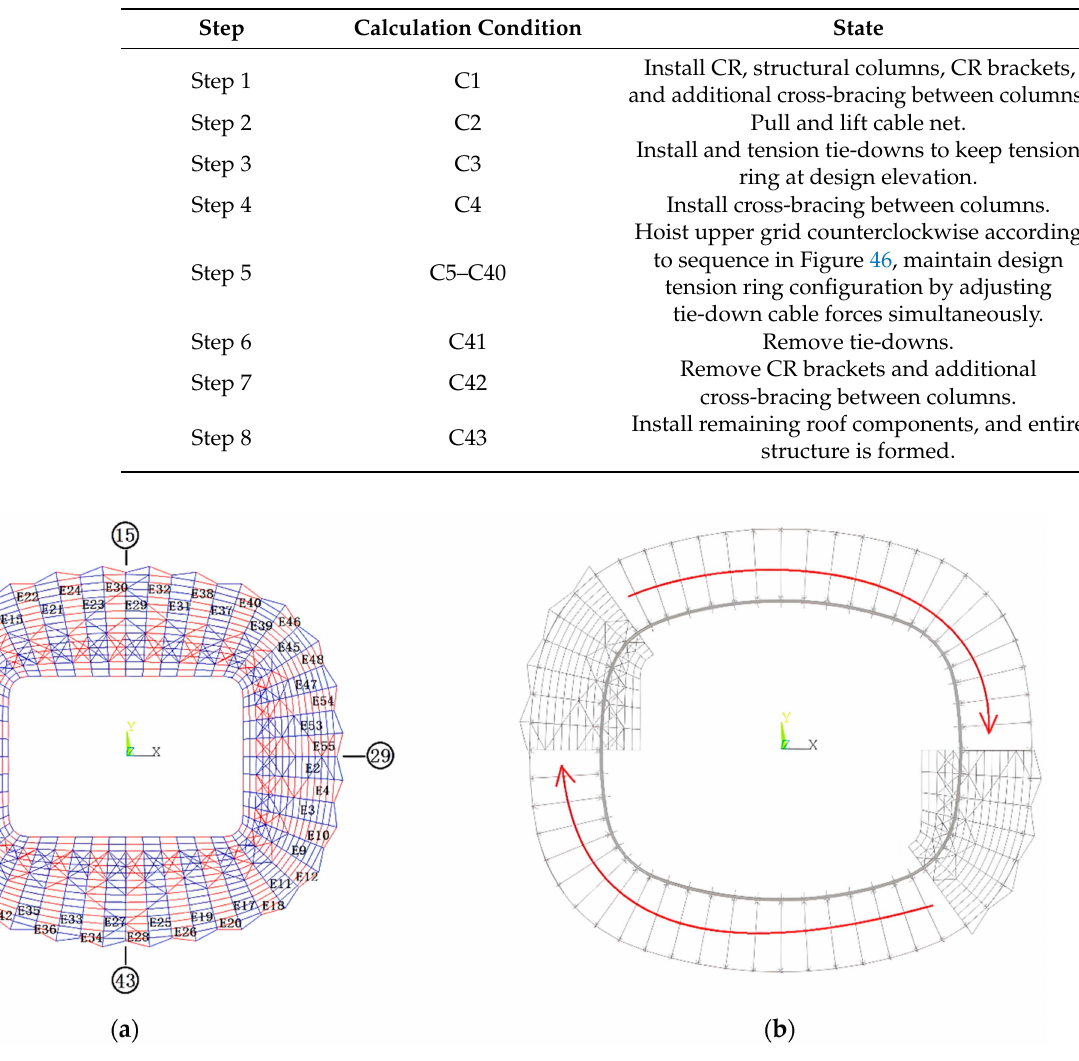
Table 18. Calculation conditions during construction.